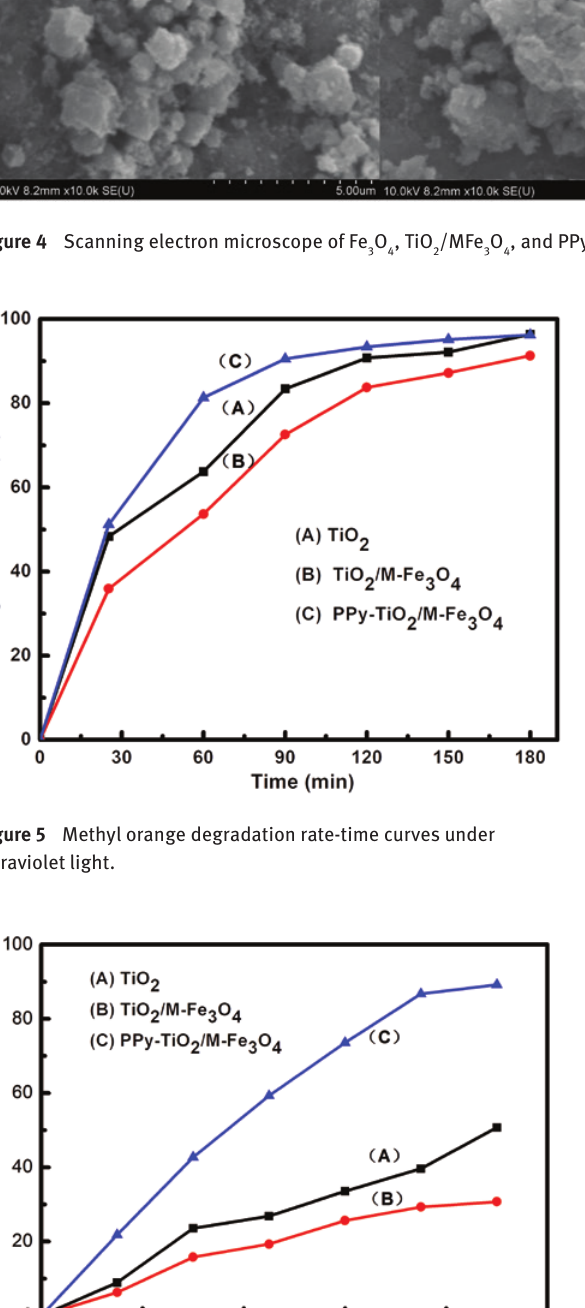
can be found the change of degradation rate under solar radiation was larger than that under ultraviolet radiation. When degradation time was fixed at 90 min, for